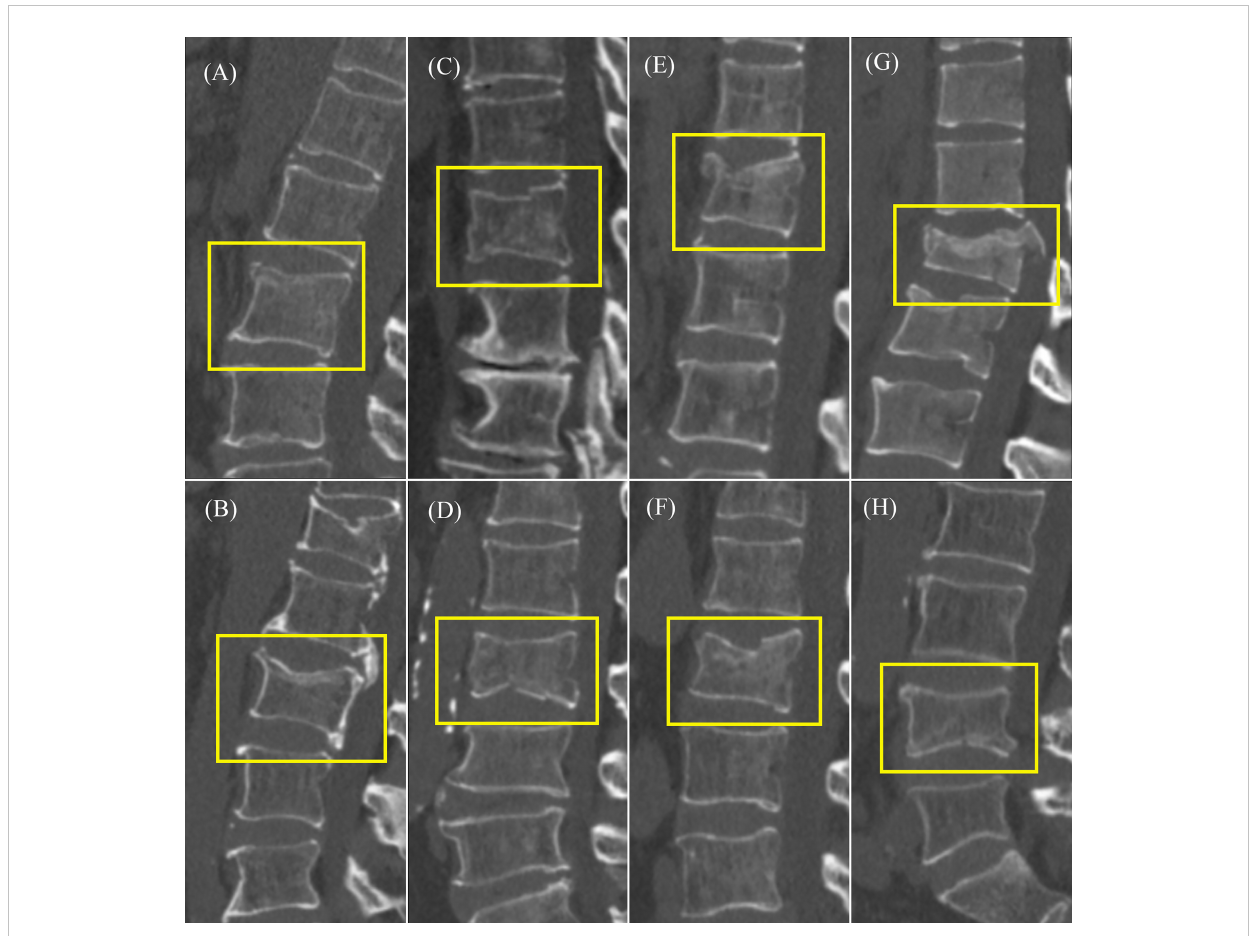
FIGURE 7 Example of type A classi fi cation test results. (A) Correctly identi fi ed type A1. (B) Misidenti fi ed A3 type as A1 type. (C) Correctly identi fi ed type A2. (D) Misidenti fi ed A4 type as A2 type. (E) Correctly identi fi ed type A3. (F) Misidenti fi ed A1 type as A3 type. (G) Correctly identi fi ed type A4. (H) Misidenti fi ed A3 type as A4